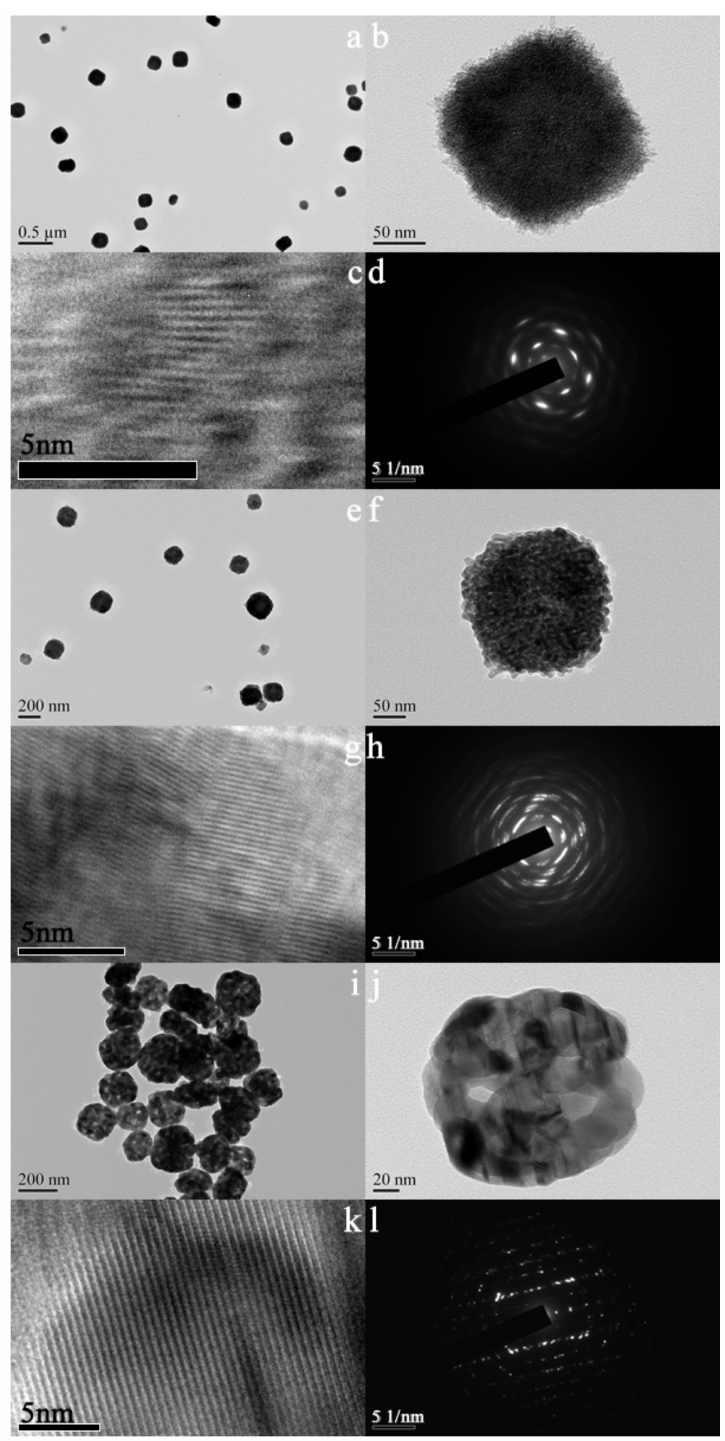
Figure 3. TEM images ( a – c , e – g , i – k ) and electron di ff raction patterns ( d , h , l ) of as-synthesized ( a – d ) and calcined zirconia ( e – h ) calcined at 723 K; ( i – l ): calcined at 923